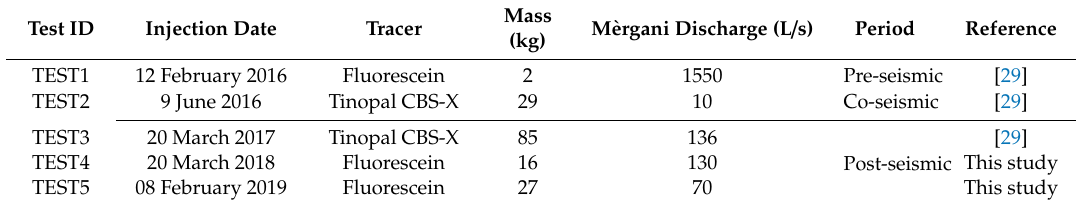
Table 2. Characteristics of the tracer tests conducted in the